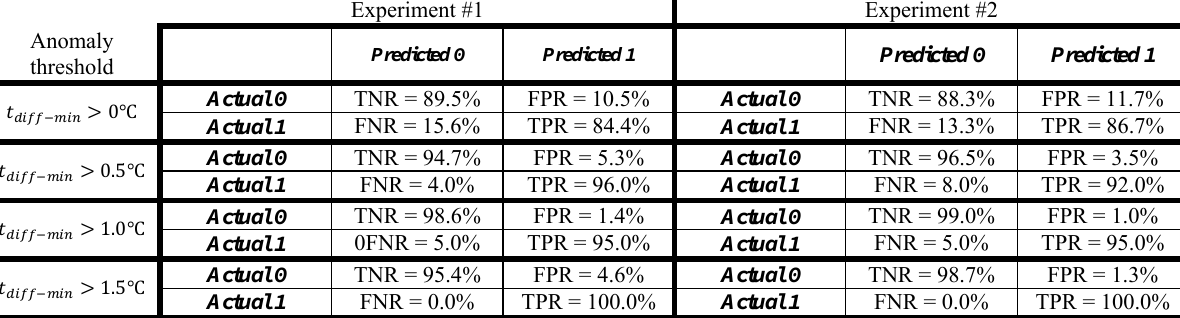
Table 3 Cross validation classification